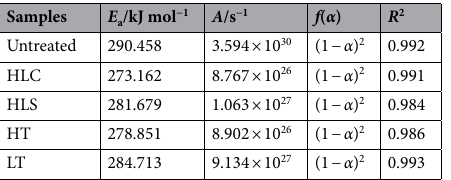
Table 6. The calculated E a , A and f ( α ) of adiabatic